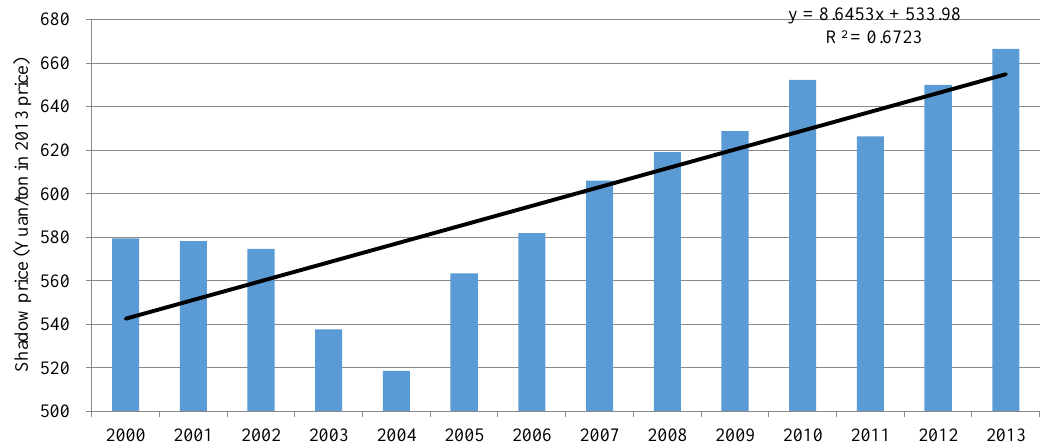
Figure 11. Weighted mean CO 2 emission shadow price, 2000–2013. Note: carbon emission is used as the weighting factors.